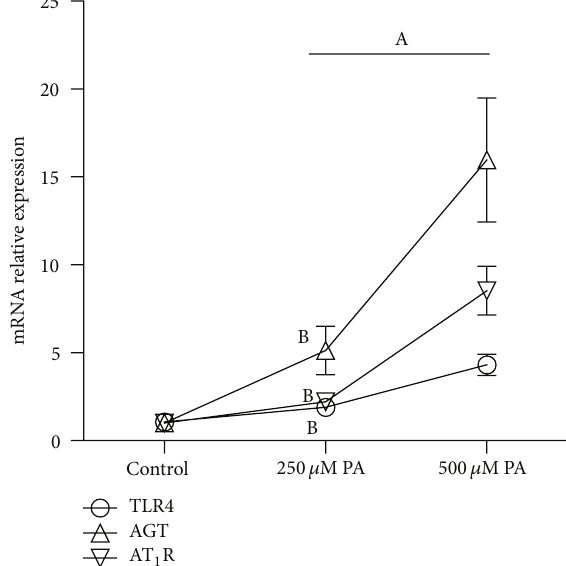
Figure 1: mRNA expression of TLR4, AGT, and AT 1 R in 3T3-L1 adipocytes induced by PA. Data are presented as mean ± SD. (A) 𝑃 < 0.05 versus control, (B) 𝑃 < 0.05 versus 500 𝜇 M PA ( 𝑥 ± 𝑠 , 𝑛 = 9 ).